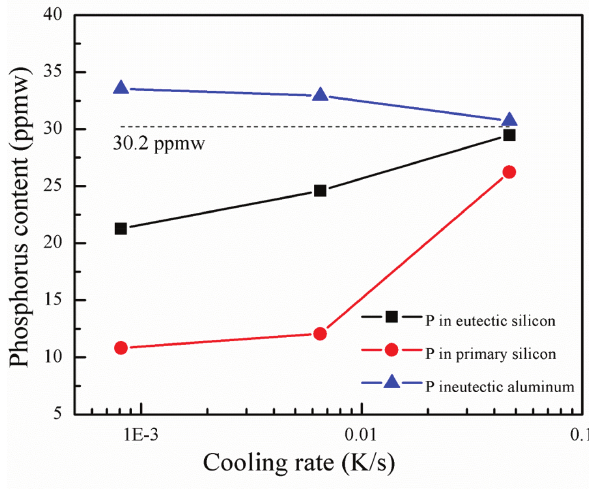
Figure 6: The phosphorus contents in experiment series